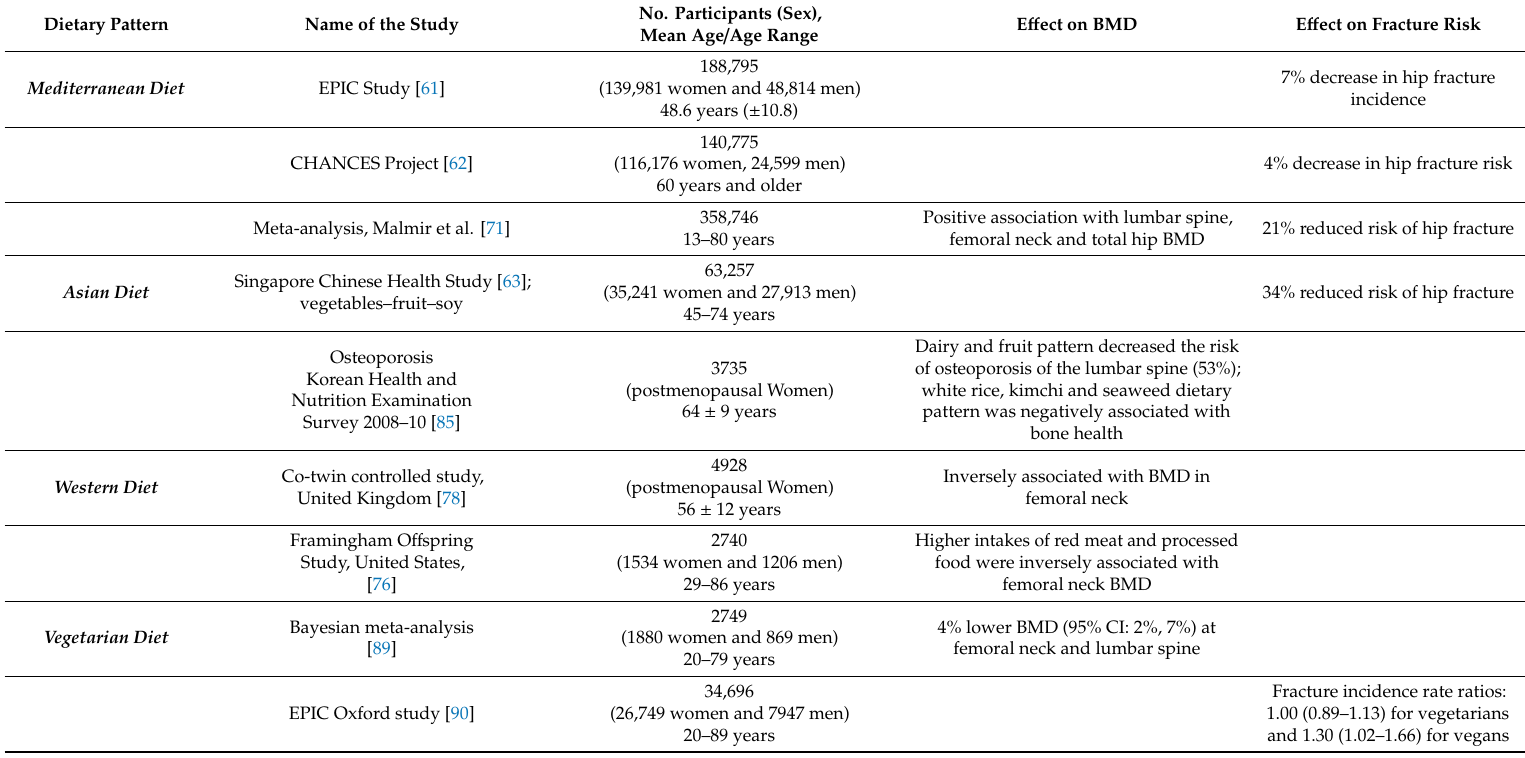
Table 2. Summary of larger studies relating bone status to each dietary